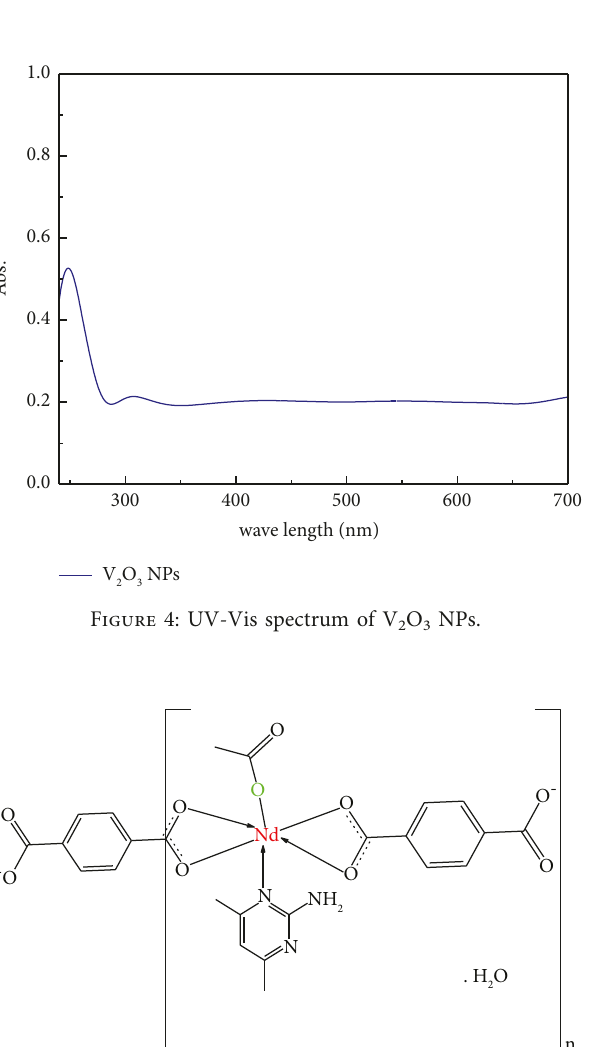
Figure 3: UV-Vis spectrum of Cr